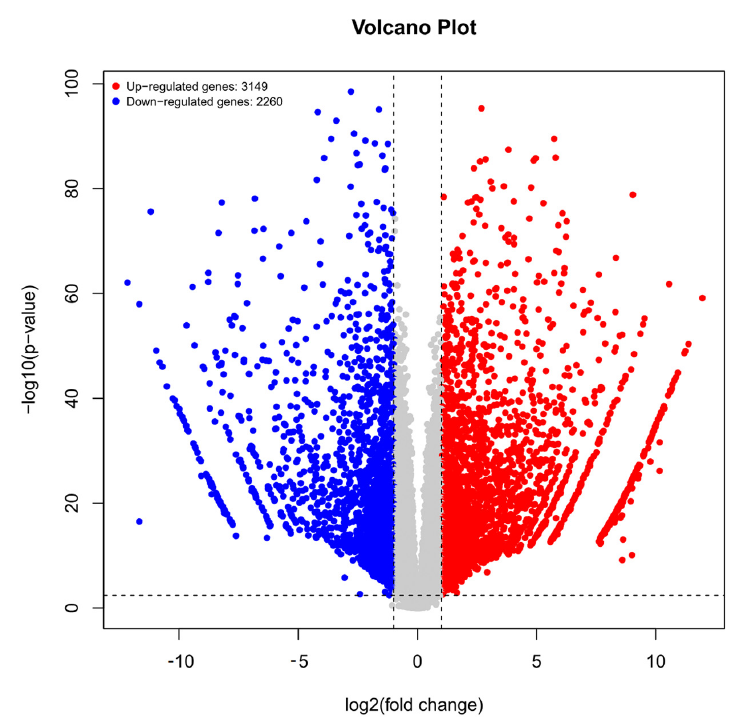
Figure 6. Volcano plot of DEGs between control and COS treatment. Red dots represent differentially up-regulated genes; blue dots represent differentially down-regulated genes, and gray dots represent genes with no significant difference.